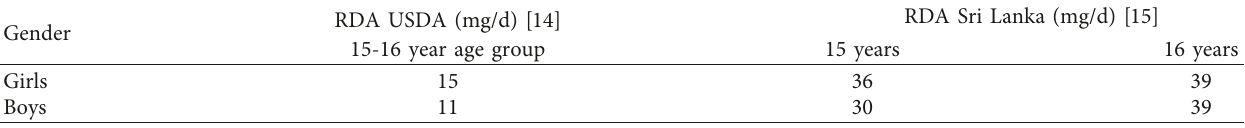
Table 1: RDA for iron in boys and girls in the 15-16 age